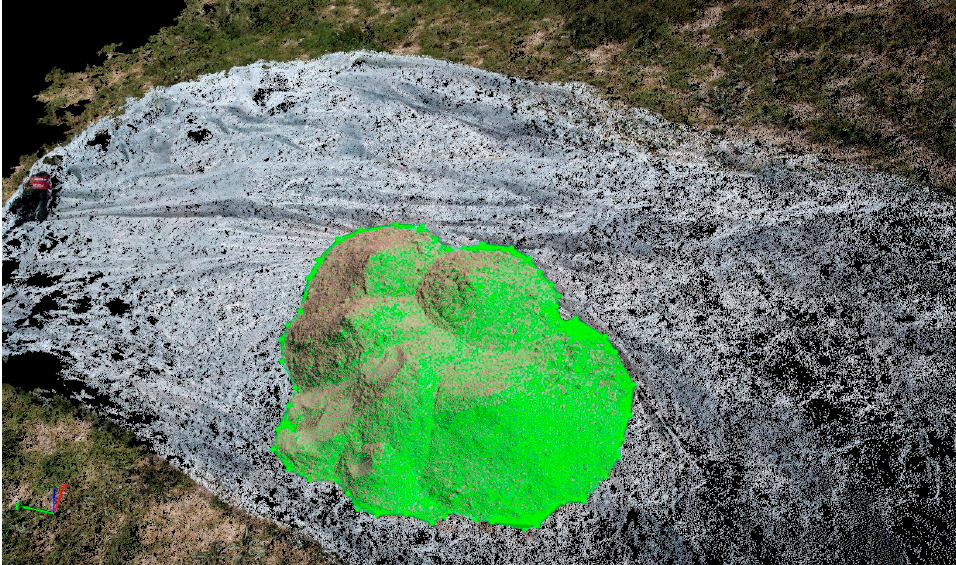
Figure 3. Stockpile Volume Calculation in point cloud model at Laboratory Site.